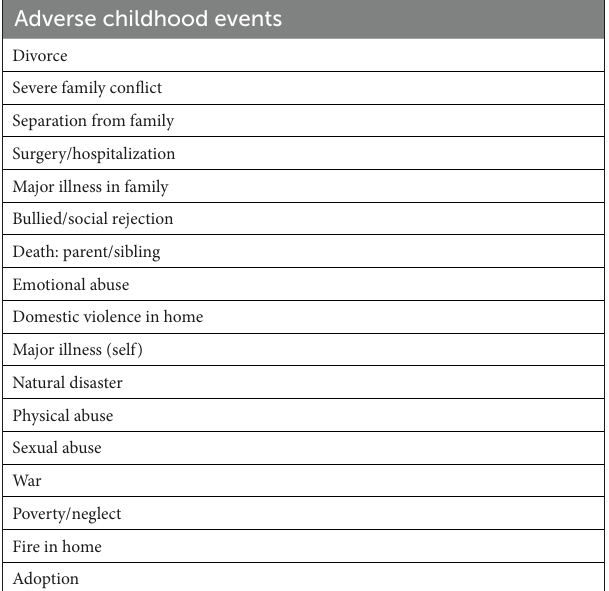
TABLE 2 17 adverse childhood events assessed using the Early Life Stress